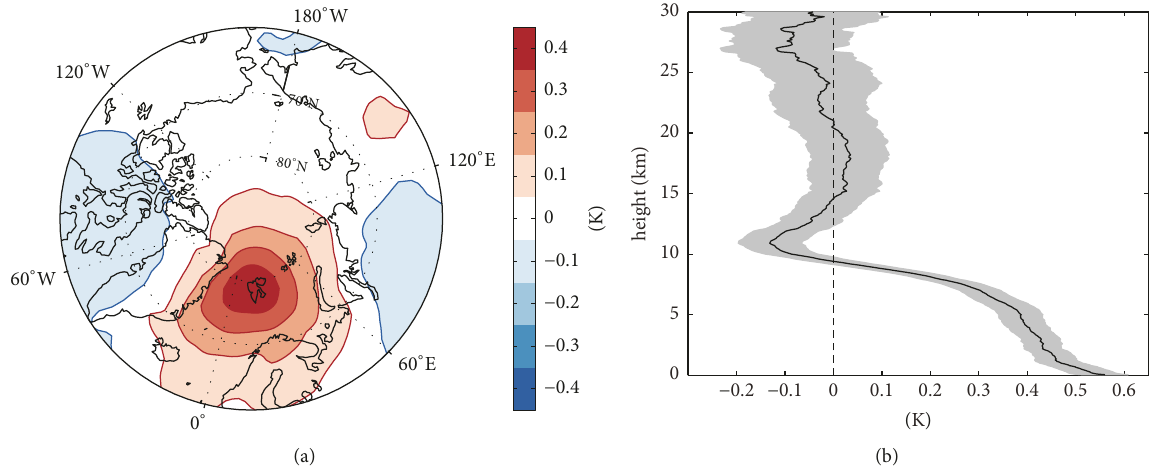
Figure 5: (a) Difference in 850 hPa temperature between an average day when an ATL-box trajectory reached Ny-˚Alesund and an average day for non-ATL-box trajectories, multiplied by the increase in fraction of ATL-box days from P1 to P2 (second term on the right in (1)) for ERA-Interim. (b) The same analysis as (a), but as a vertical plot based on temperatures from the Ny-˚Alesund long-term radiosonde record. Grey shading indicates the 95% confidence